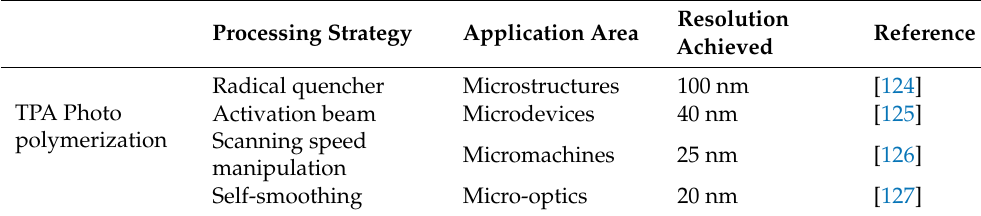
Table 2. Different printing strategies and applications of TPA